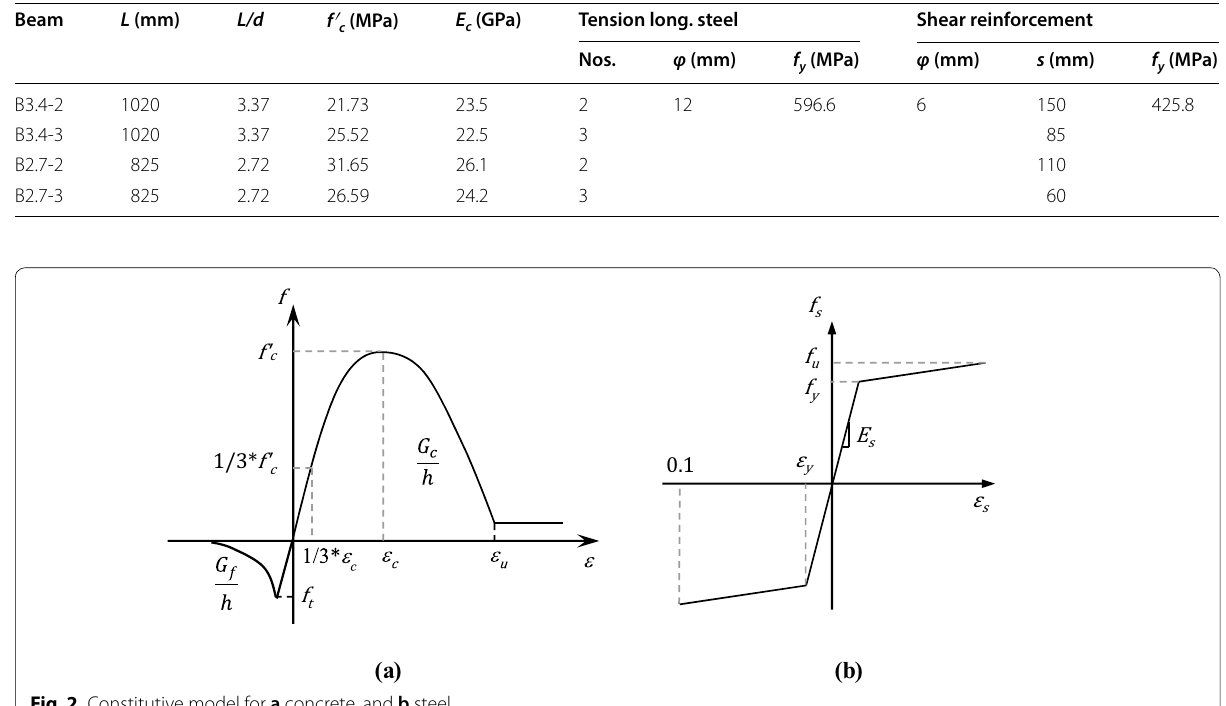
Fig. 2 Constitutive model for a concrete, and b